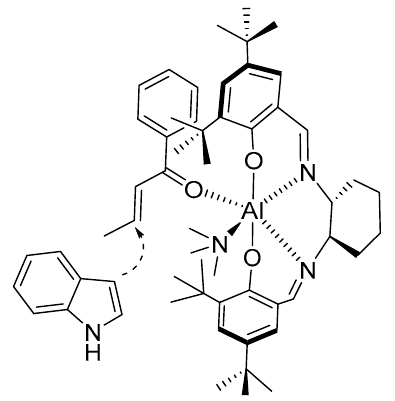
Figure 5. Proposed transition state for addition of indoles as nucleophiles to unsaturated ketones, in the presence of an Al(salen) complex.